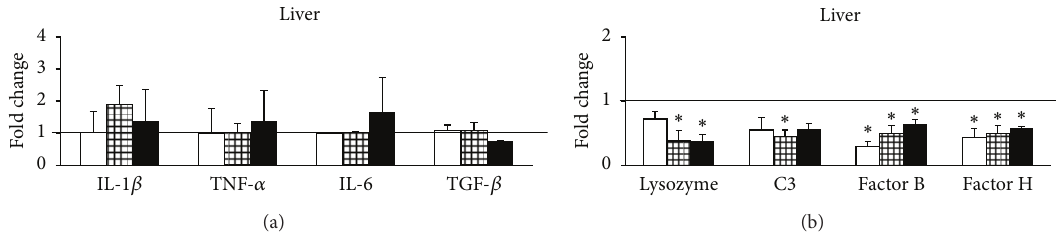
Figure 2: Real-time RT-qPCR analysis of IL-1 𝛽 , TNF- 𝛼 , IL-6, TGF- 𝛽 (a), lysozyme, C3, factor B, and factor H (b) in the liver of O. mykiss 1 (open bars), 5 (gridded bars), and 10 (closed bars) days after ip implantation of coconut oil alone (control) or containing 50 𝜇 g/g bw cortisol. Relative expression levels were normalized to 18S rRNA and fold changes were calculated against control. Values represent the means and SEM ( 𝑛 = 6 per group). Significant differences are highlighted as ∗ versus control ( 𝑃 < 0.05 ). The horizontal line originating at 𝑦 = 1 denotes the control group against which the expression was